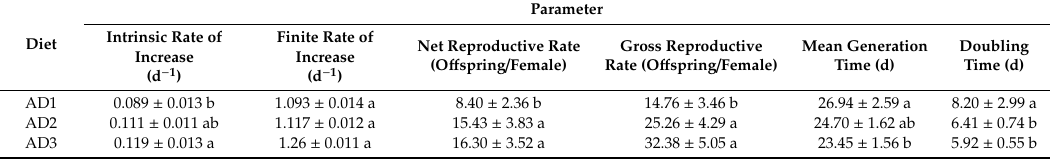
Table 4. Mean ± SE of the estimated life table parameters (n = 30) of S. gilvifrons fed on three di ff erent artificial